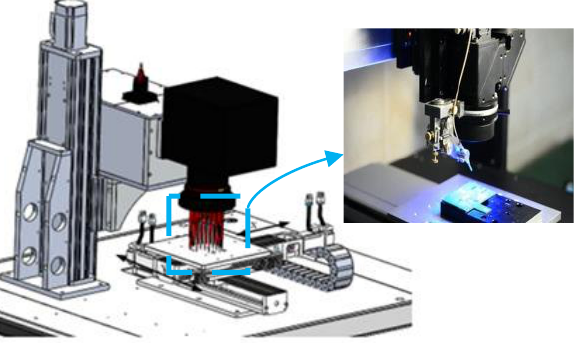
Figure 1. Schematic diagram of system movement.